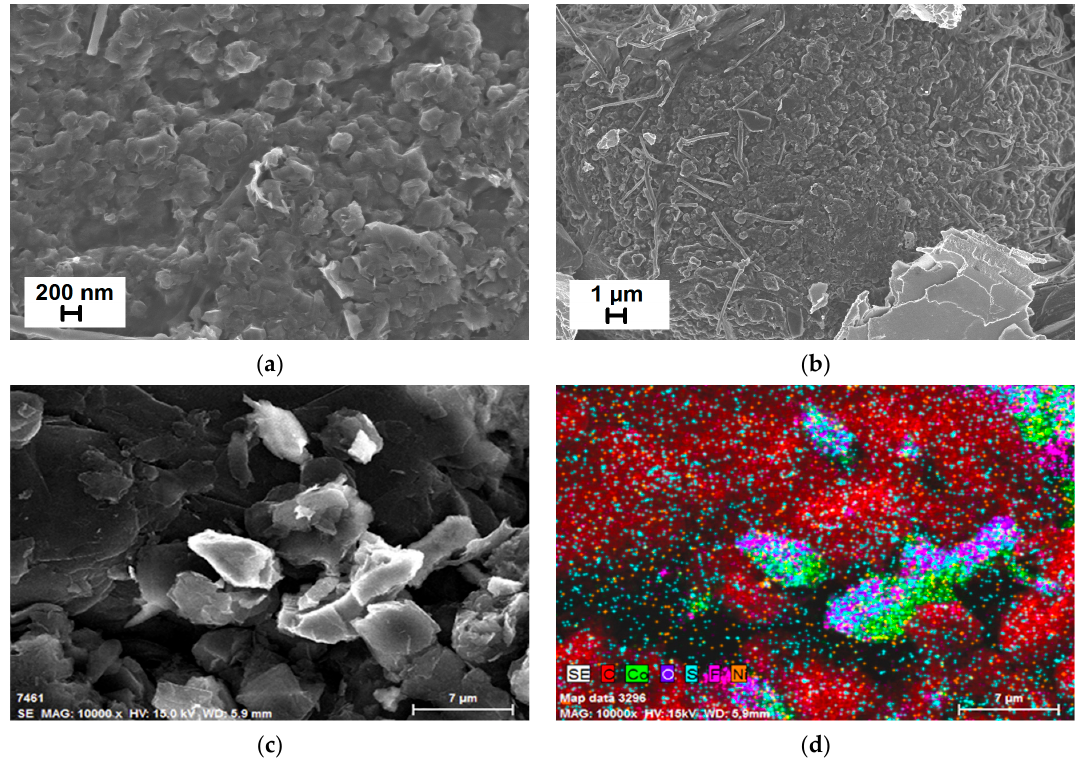
Figure 5. SEM images of sample 3, where ( a – c ) show different scales, while ( d ) is an EDS map of elements. Meshram P. et al. [34] investigated leaching residues consisting of LiCoO 2 , of Li 2 CoMn 3 O 8 and (Li 0.85 Ni 0.05 )(NiO 2 ) that were leached with H 2 SO 4 , and revealed that the morphology of the final product is very complex. Similarly to our results, the particles of